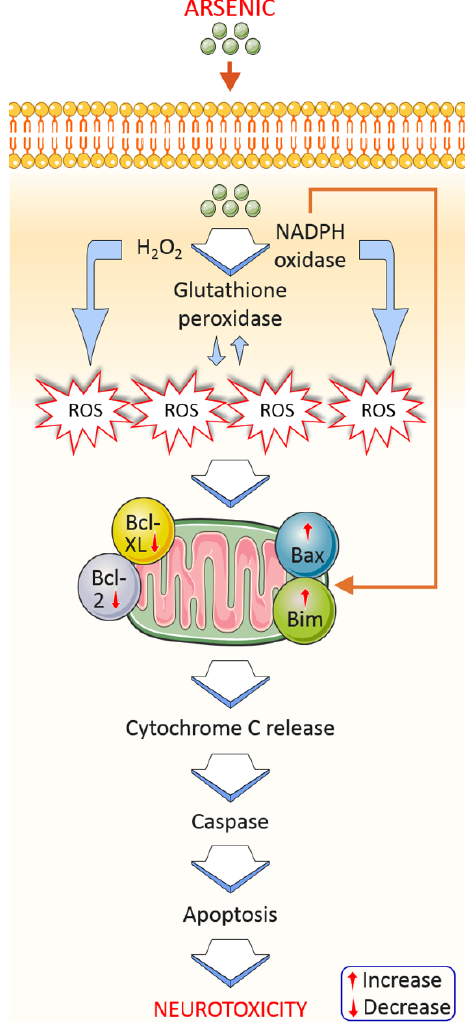
Figure 4. Arsenic exposure induces apoptotic factors from mitochondria to cause neurotoxicity. Mi- tochondria are the main target in arsenic-mediated neurotoxicity. Arsenic-mediated oxidative